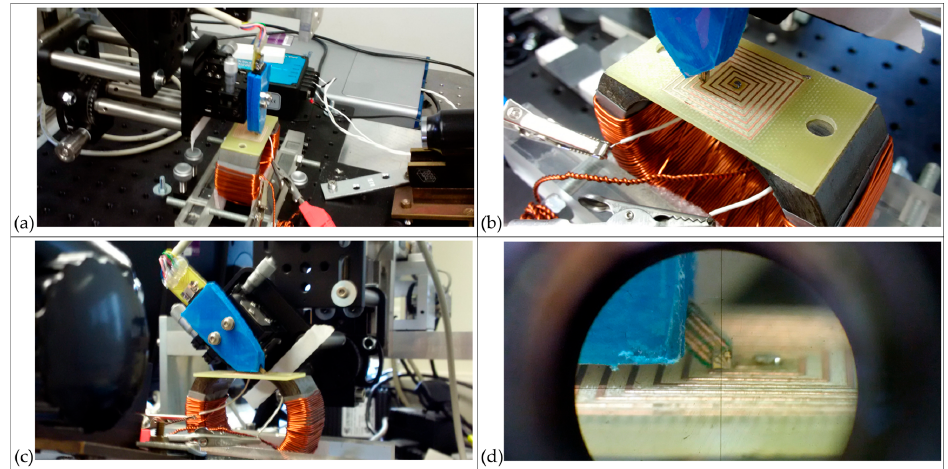
Figure 4. Photographs of the system scanning the square planar coil: ( a , b ) with the TMR sensor perpendicular; ( c , d ) with the TMR sensor at 45° supported by a precision goniometer. The centre of rotation is precisely aligned to the centre of the sensor’s active area.